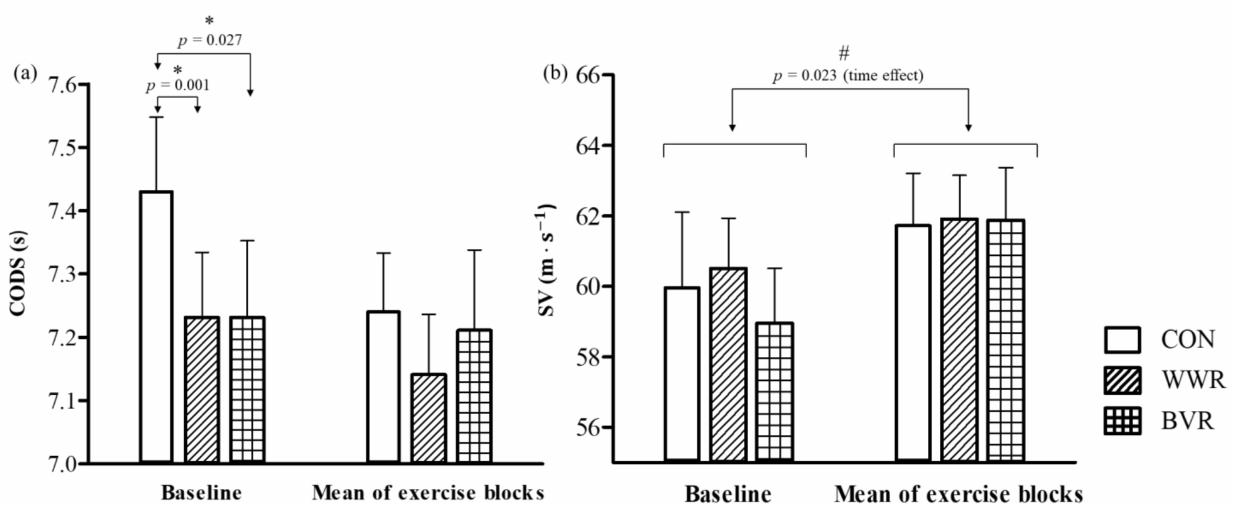
Figure 4. Change of direction speed, CODS ( a ) and smash velocity, SV ( b ) at baseline relative to mean values of exercise blocks 1 to 4. * Interaction effect of trial × time p < 0.05, and post hoc tests revealed significantly faster CODS in weighted wearable resistance (WWR) and banded variable resistance (BVR) as compared to CON condition at baseline. # Main effect of time p < 0.05, and post hoc tests revealed significantly faster SV during the 4 exercise blocks than at baseline under all three warm-up conditions.